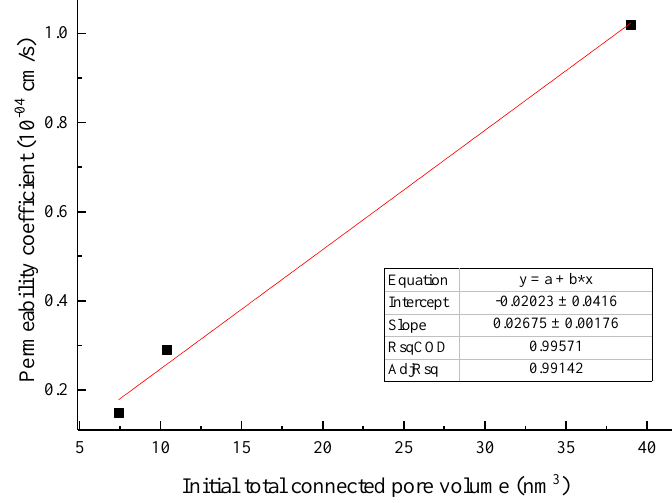
Figure 25. Fitting curve of the connected pore volume and permeability coefficient.